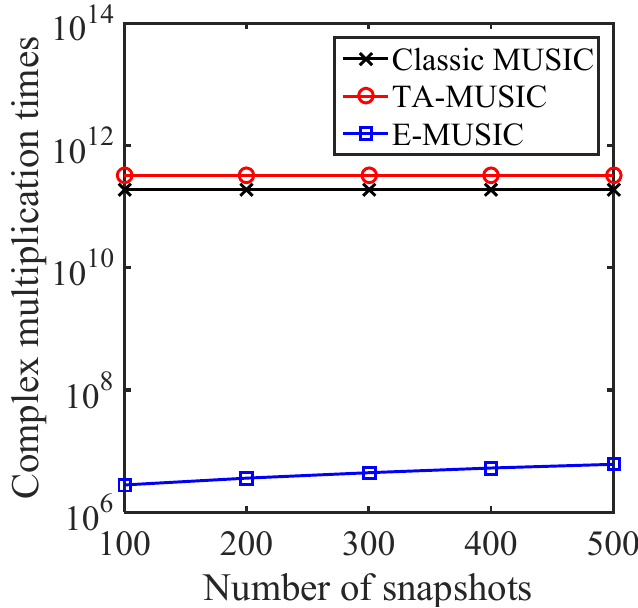
Figure 3. Algorithm complexityaccording to number of snapshots.